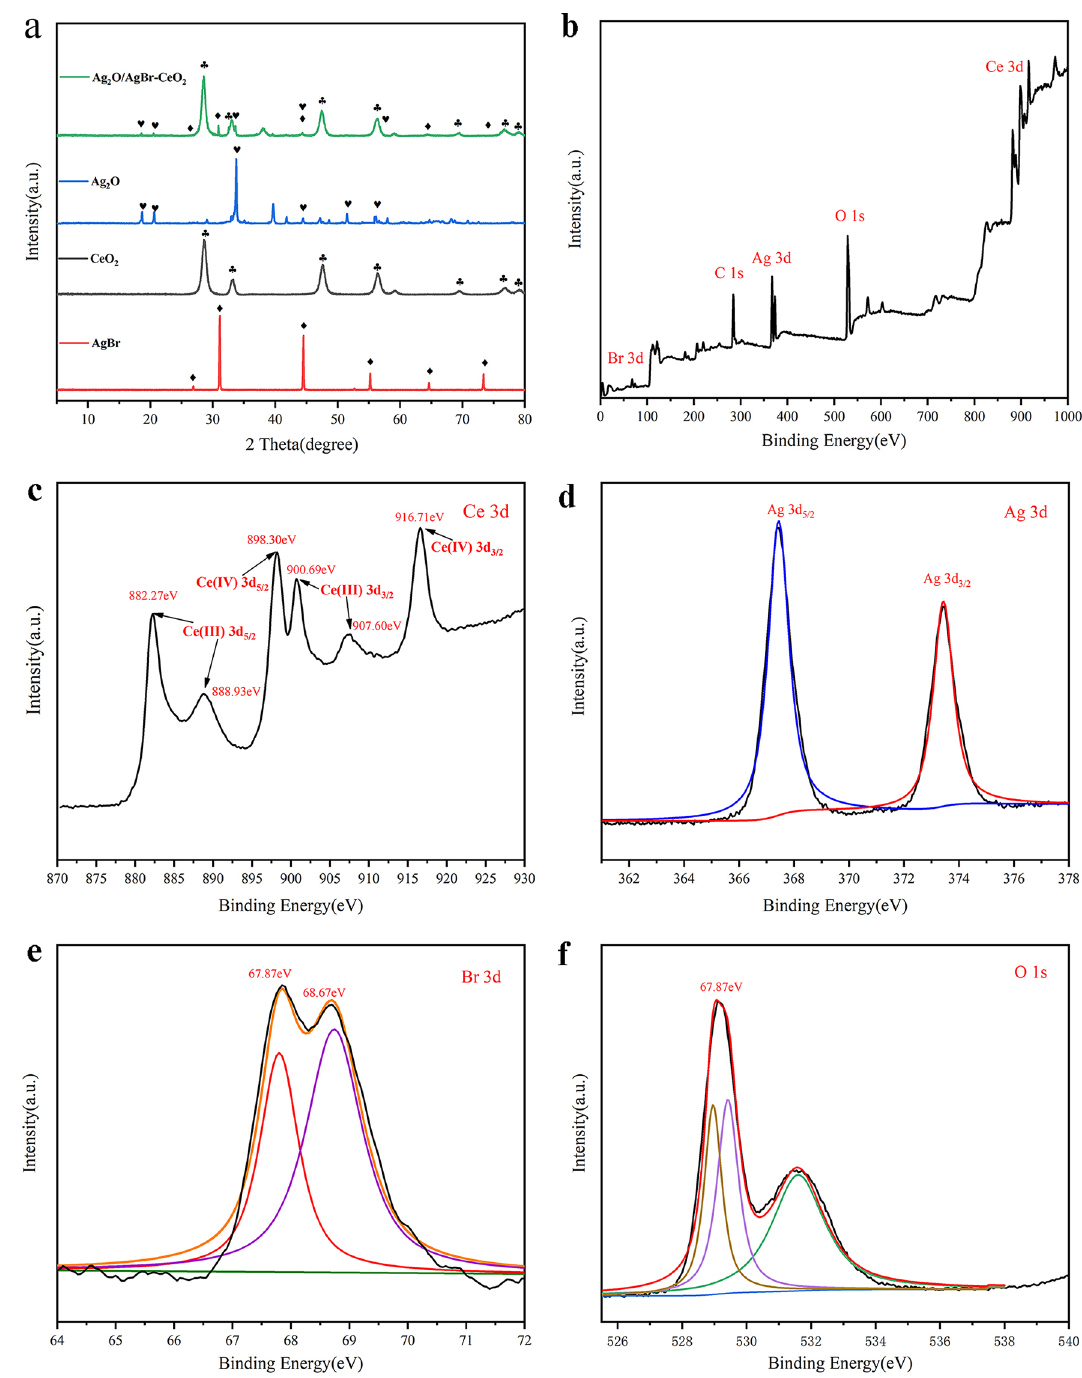
Figure 2. ( a ) XRD patterns of CeO 2 , Ag 2 O, AgBr and ACA-2 composites and ( b – f ) XPS spectrum of